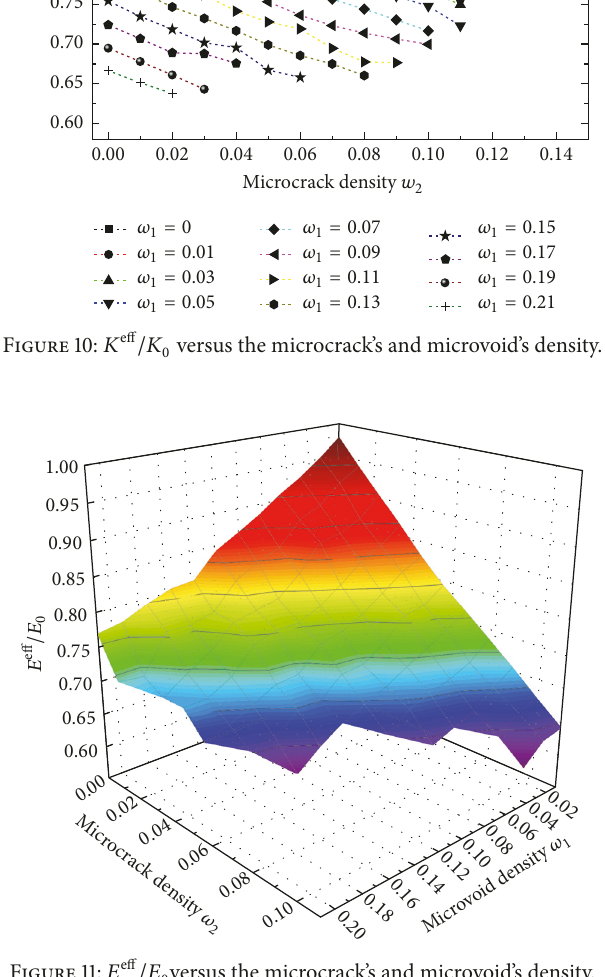
From this simulation, we can see that, under different microvoid densities, the two effective moduli 𝐸 eff and 𝐾 eff decrease linearly with the increase in the microcrack’s density.